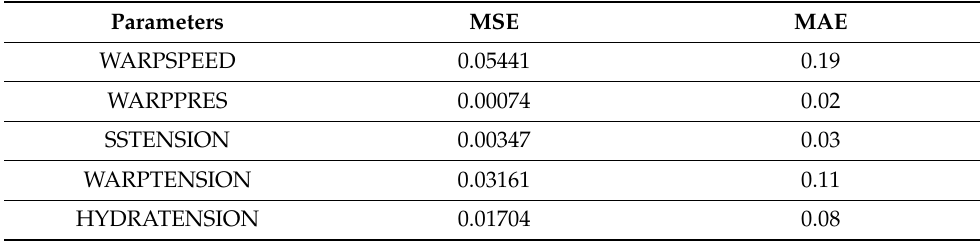
Table 7. Linear regression results for the warping process.